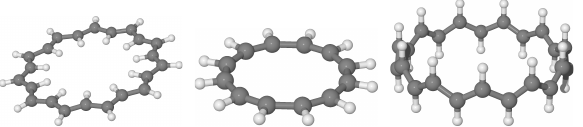
Figure 5. The anti-, cis- and trans-annulene structures considered in this work.